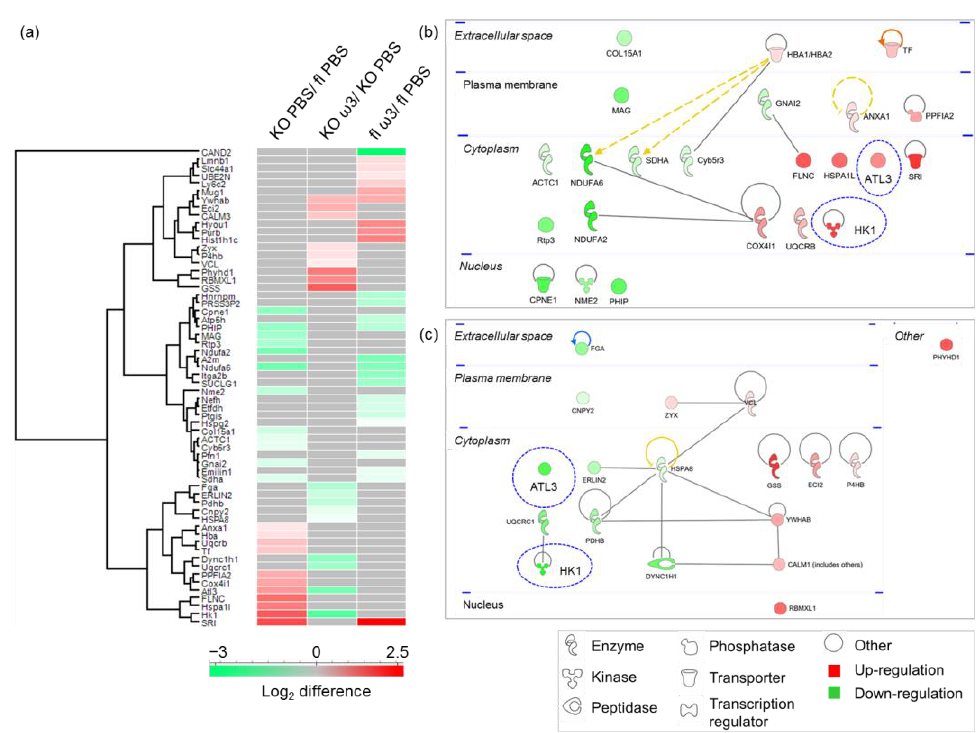
Figure 2. Differentially expressed protein profiles of the ophthalmic artery. ( a ) Hierarchical clus- tering of the differentially expressed proteins represented in a heat map. The up-regulated proteins are shown in red, and the down-regulated proteins are in green. The protein–protein interaction depicts the networks of differentially expressed proteins in the ophthalmic artery of the KO mice ( b ) before and ( c ) after 7-day intake of ω -3 PUFA. Colours red and green represent increment and decrement of protein abundance, respectively, with different colour intensities that correspond to the degree of differential expression. Proteins are annotated according to their localization in different cellular compartments and are depicted as different shapes representing the functional classes of the proteins (e.g., enzyme, transcription regulator, transporter, etc.). Blue dotted circles highlight the distinct change in protein regulation profiles following ω -3 PUFA supplementation.